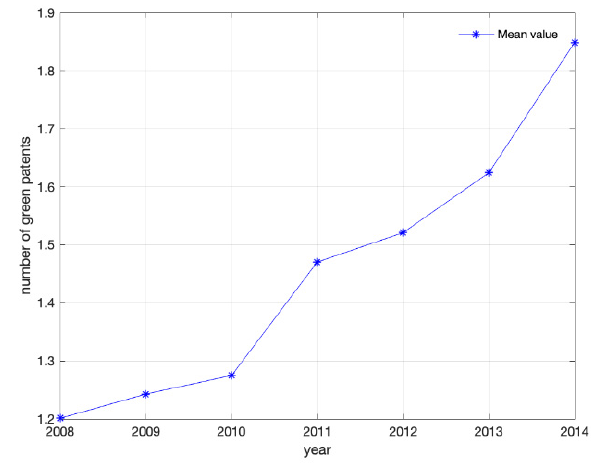
Figure 1. Green innovation performance trend (2008 to 2014).